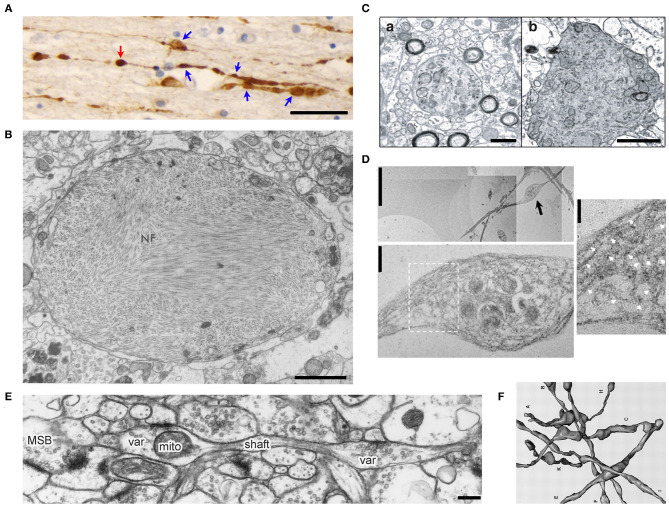
Morphology of axonal varicosities in injured, diseased or normal brains. (A), Post-mortem APP immunoreactivity within the corpus callosum of a TBI patient displayed multiple varicosities (blue arrows) along individual axons (Tang-Schomer et al., 2012). The swelling without a visible thin linking axon is a potential terminal bulb (red arrow). Scale bar, 30 μm. (B), The transmission electron microscope (TEM) image of an axonal varicosity or swelling filled with neurofibrils (NF) from the post-mortem cerebral cortex of a patient with Alzheimer's presenile dementia (Terry et al., 1964). Scale bar, 1 μm. (C), Ultrastructure of axonal varicosity in a mouse model of AD (Stokin et al., 2005). Degenerative changes in axonal varicosity along the fibers of the nucleus basalis of Meynert in Tg-swAPPPrp (b) but not wild-type mice (a). Scale bar, 1 μm. (D), TEM images of cultured cortical neurons from spastin−/− mice show disorganization of the microtubule (MT) network within axonal varicosities (Fassier et al., 2013). The image in the lower panel is the high magnification of axonal varicosity indicated by a blackarrow in the upper image. The image on the right is the high magnification of boxed regions, showing the tangled and bent aspect of MT filaments within the axonal varicosity. This abnormal appearance of MTs was never observed in wild-type axons, in which MTs were always organized in parallel arrays. White arrows indicate MT. Scale bars: 5 μm (upper left), 0.5 μm (lower left) and 0.25 μm (right). (E), Ultrastructural features of CA3 varicosities (Var) and axons in stratum radiatum of area CA1 in the normal rat brain (Shepherd and Harris, 1998). Longitudinally sectioned axon with two boutons, neither of which had additional PSDs or mitochondria in adjacent images. mito, mitochondria; MSB, multiple-synapse bouton; PSD, postsynaptic density. Scale bar, 1 μm. (F), Eight reconstructed axons from series electron microscopy images including axonal varicosities (Shepherd and Harris, 1998).